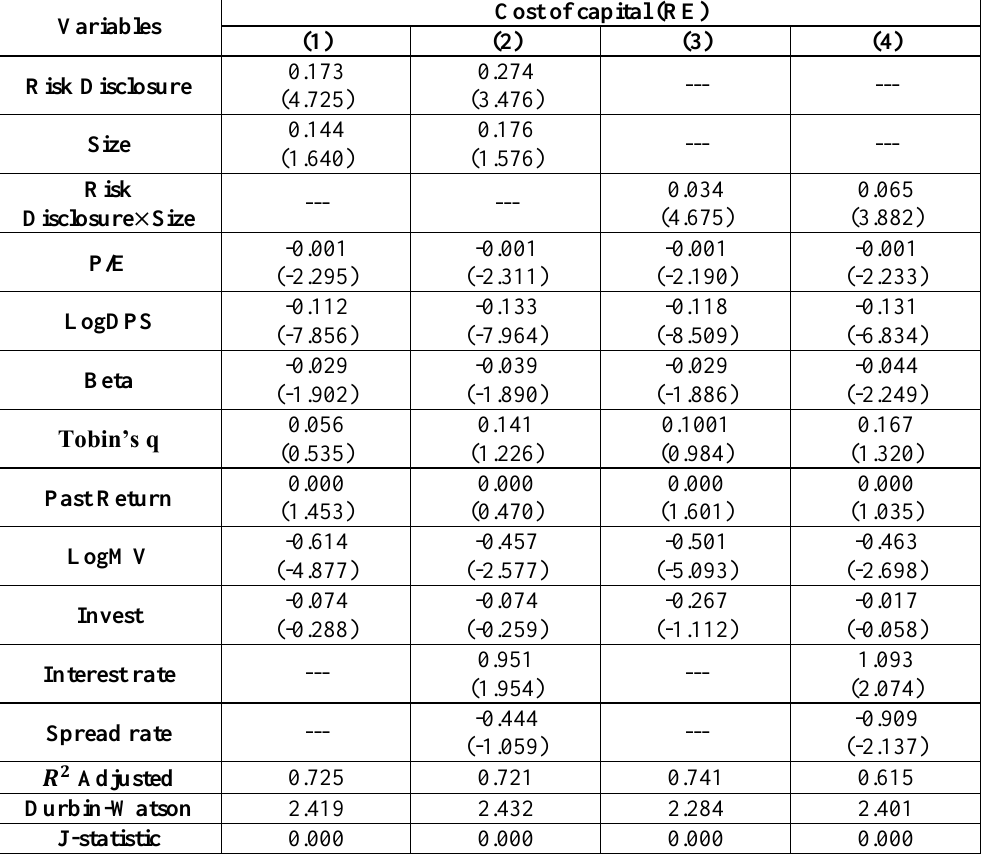
Table 6. Estimation of a regression